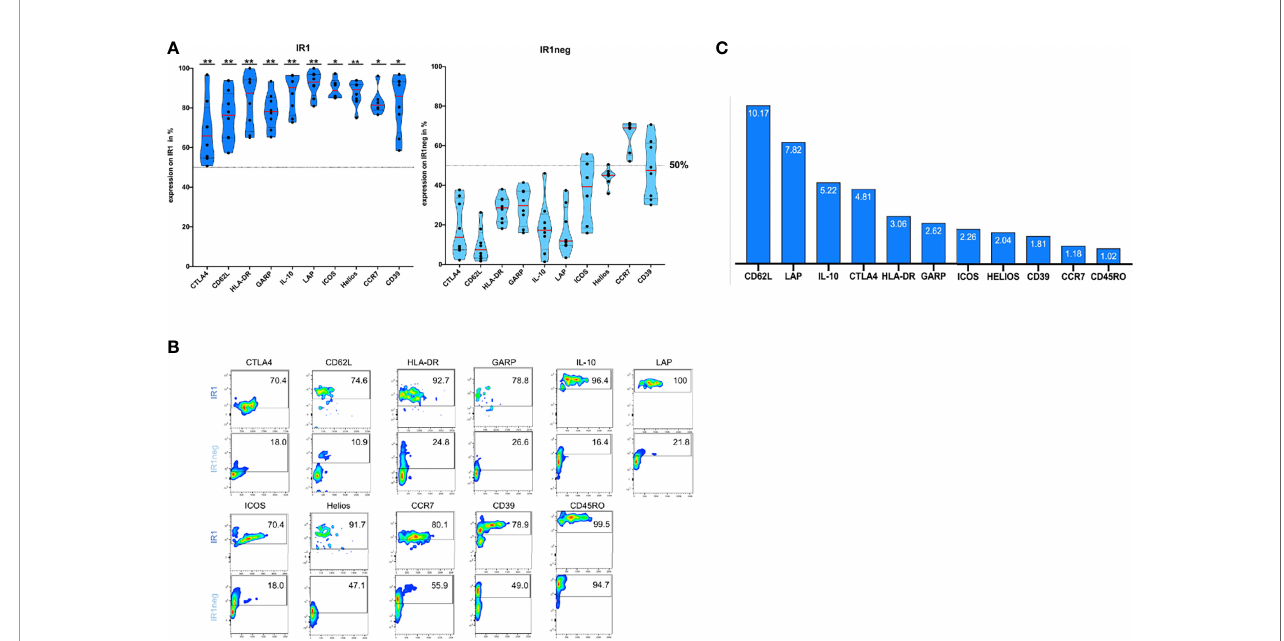
FIGURE 2 | (A) IR1 cells express multiple membrane and soluble immune suppressor molecules. Surface expression of HLA-DR, CD39, LAP, ICOS, IL-10, CTLA-4, CCR7, CD62L, GARP and Helios is higher for IR1 cells than for IR1neg Tregs after 72h IL-2 induction. Violin plots were generated using statistical software Prism GraphPad. (Gating Supplementary Figure 1.2 , for overlaid histograms from marker on IR1 versus IR1neg; Supplementary Figure 2A ). Medians indicated by red lines. P-values re fl ect **P < 0.01, *P < 0.05 whether the ratio of IR1/IR1neg is signi fi cantly different from one. (See also Table 3 ). (B) Representative example of Immunophenotyping for two subpopulations: IR1 Treg compared to IR1neg Treg, using the above ten markers plus CD45RO. Marker expression is measured on the y-axis versus side scatter (SSC-A) on the x-axis. Smoothed pseudo-color dot plots are shown. (Gating Supplementary Figure 1.2 , for overlaid histograms from marker on IR1 versus IR1neg; Supplementary Figure 2A , MFI- Values (B) . (C) Ratio (IR1 cells/IR1neg Tregs) of median percentage Tregs with the respective marker: CD62L, LAP, IL-10, CTLA-4, HLA-DR, GARP, ICOS, HELIOS, CD39, CCR7 and